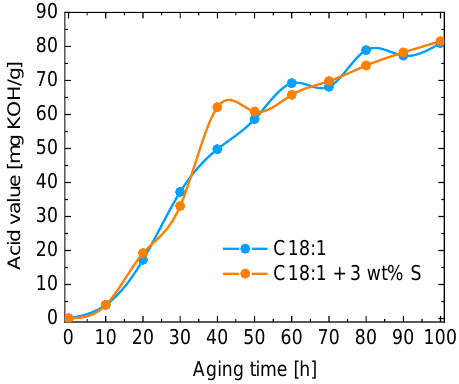
Figure 13. Comparison of acid value over aging time of C18:1 (blue) and C18:1 + 3 wt% S (orange) by using titration method according to EN 14,104 ( n = 2).